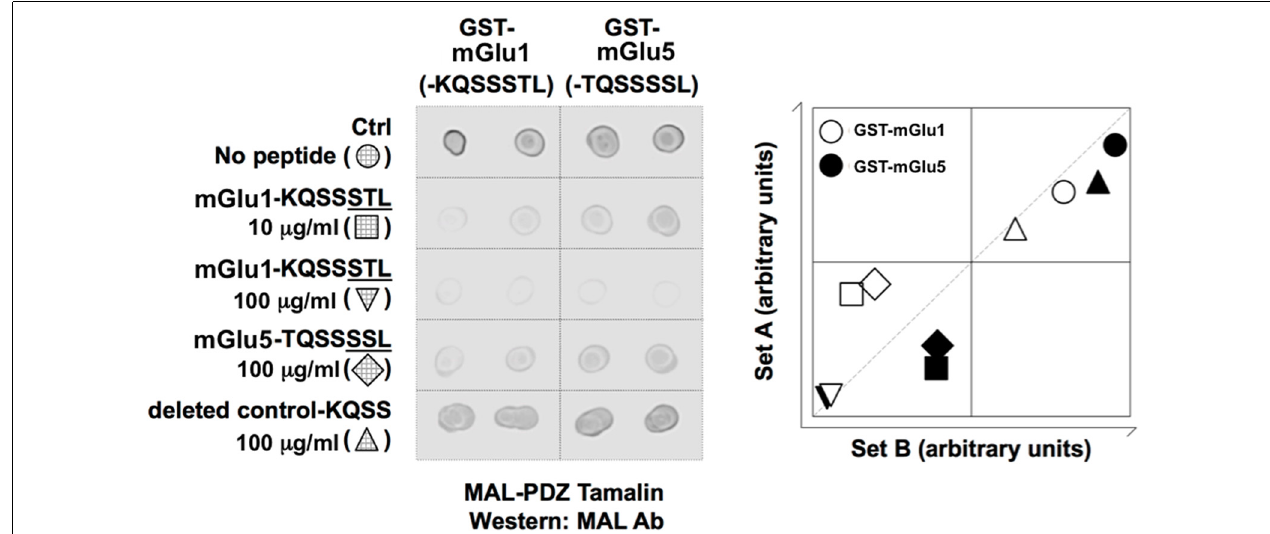
FIGURE 1 | Blocking peptides (pep-mGluR1 and 5) inhibit interaction between mGlu1- or mGlu5 receptors and Tamalin. Left : dot blot shows that mGlu1-KQSSSTL and mGlu5-TQSSSSL peptides inhibit interaction between GST-mGlu1 (-KQSSSTL) and GST-mGlu5 (-TQSSSSL). Abbreviations: Ab, antibody; Ctrl, control; GST, glutathione-S-transferase; MAL, maltose binding protein; PDZ, PSD-95/discs-large/ZO-1. Right : a scatter plot for each spot was obtained by plotting the density in the first array experiment ( x -axis) against that obtained in the second array experiment ( y -axis). The samples lying along the x/y axis indicated consistency between array experiments. The samples lying at the extremities in this analysis displayed the highest